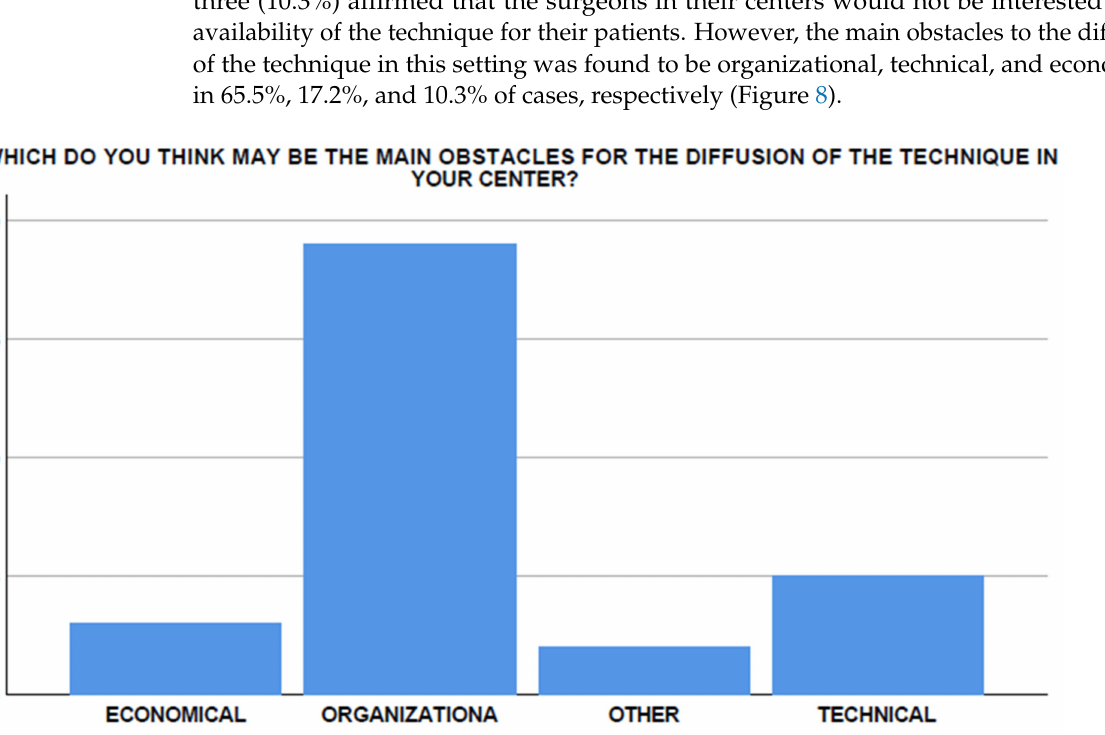
Figure 8. Perceived obstacles in EUS-GEA diffusion in the setting of afferent limb